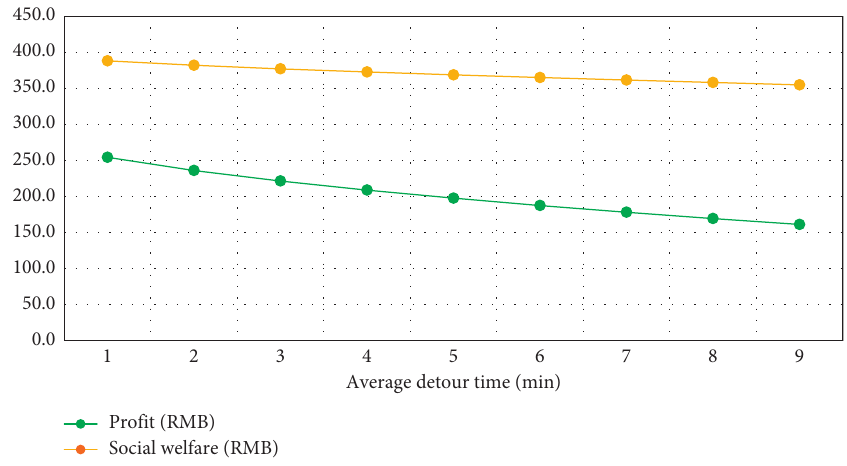
Figure 10: Effects of the average detour time (Case 1).